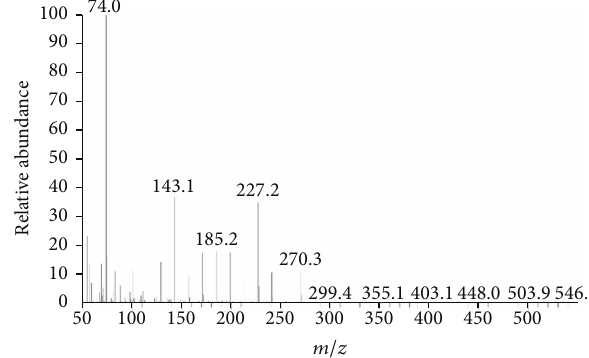
Figure 3: Spectra showing octadecanoic acid as a major fatty acid.